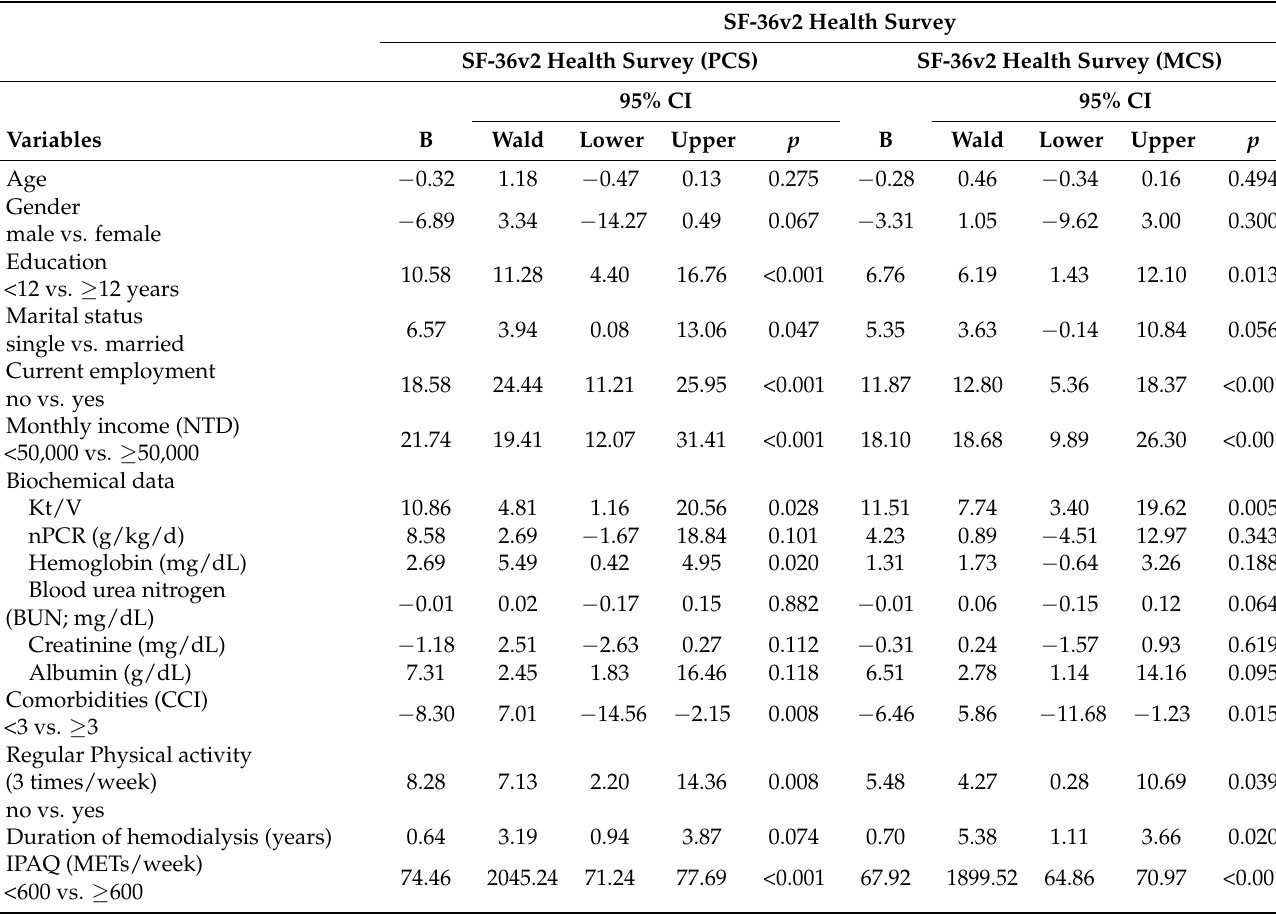
Table 2. Analysis of factors associated with health-related quality of life and sociodemographic characteristics ( n =